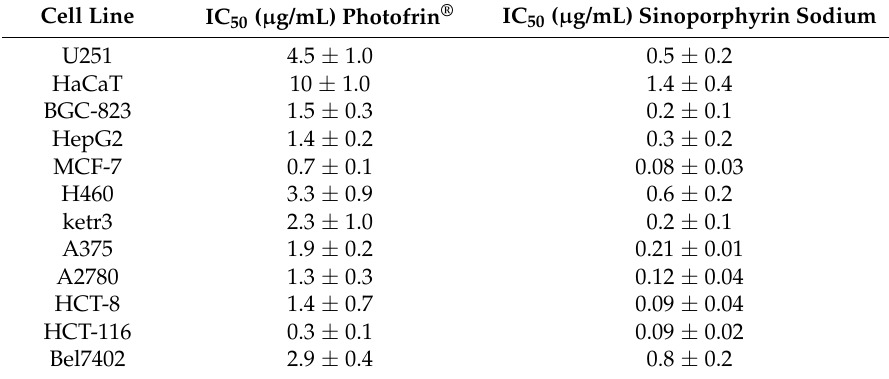
Table 2. IC 50 values of Photofrin-PDT and sinoporphyrin sodium-PDT towards human cancer cell lines and immortal keratinocyte cells (X ± SD).